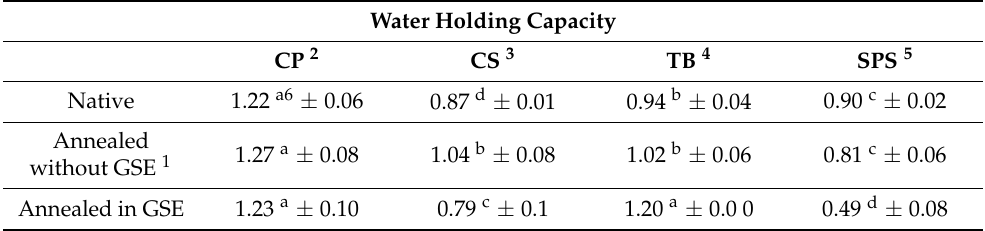
Table 5. The effect of enzyme extract (GSE) on the water holding capacity of starches annealed at 60 ◦ C for 60 min.